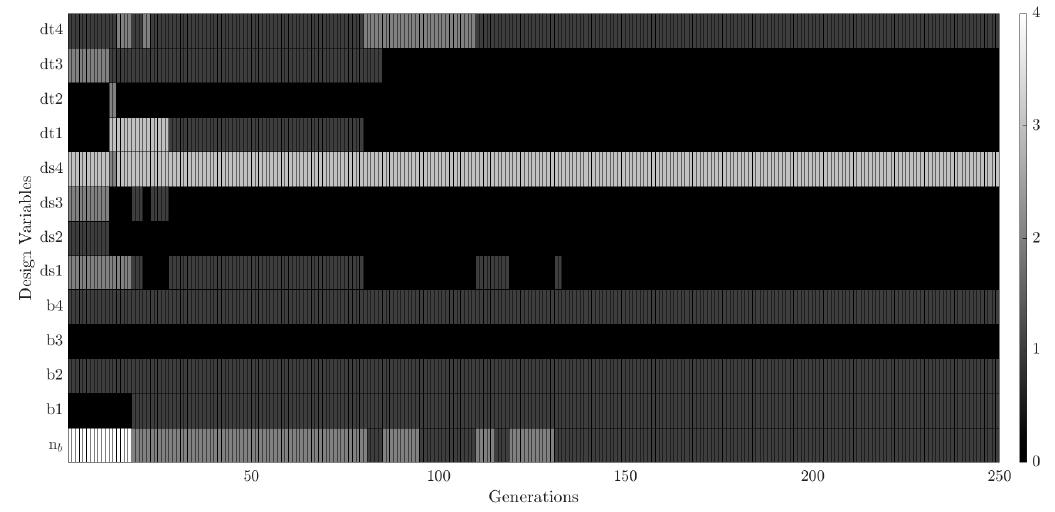
Figure 14. Variation of number of batteries and solar panels over generations where the color denotes the number.